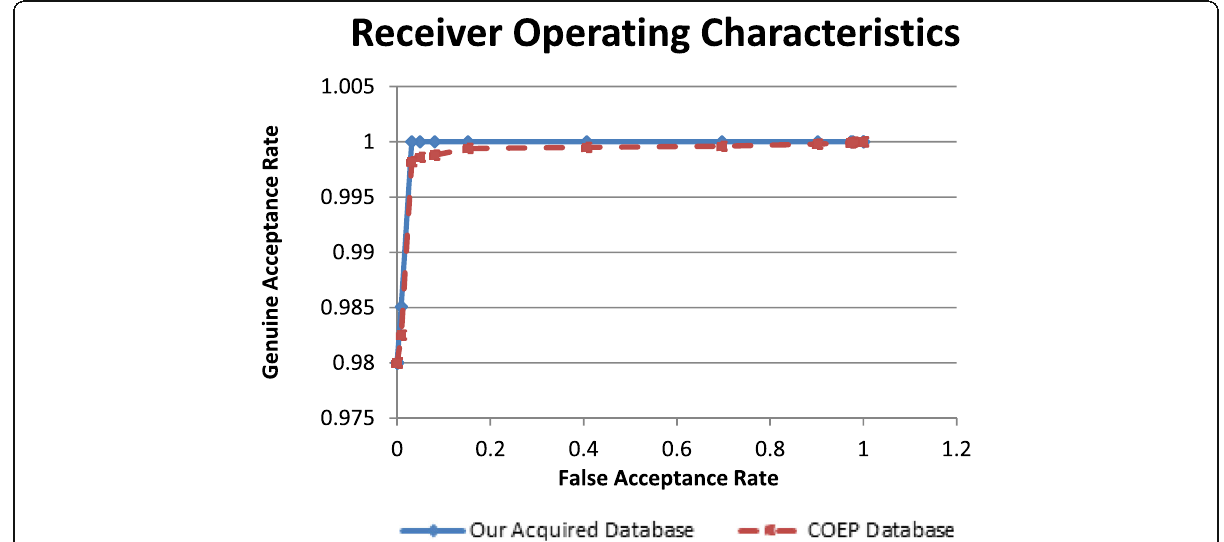
Fig. 11 ROC of palm print modality for both the databases using optimal weights algorithm for approximate and horizontal